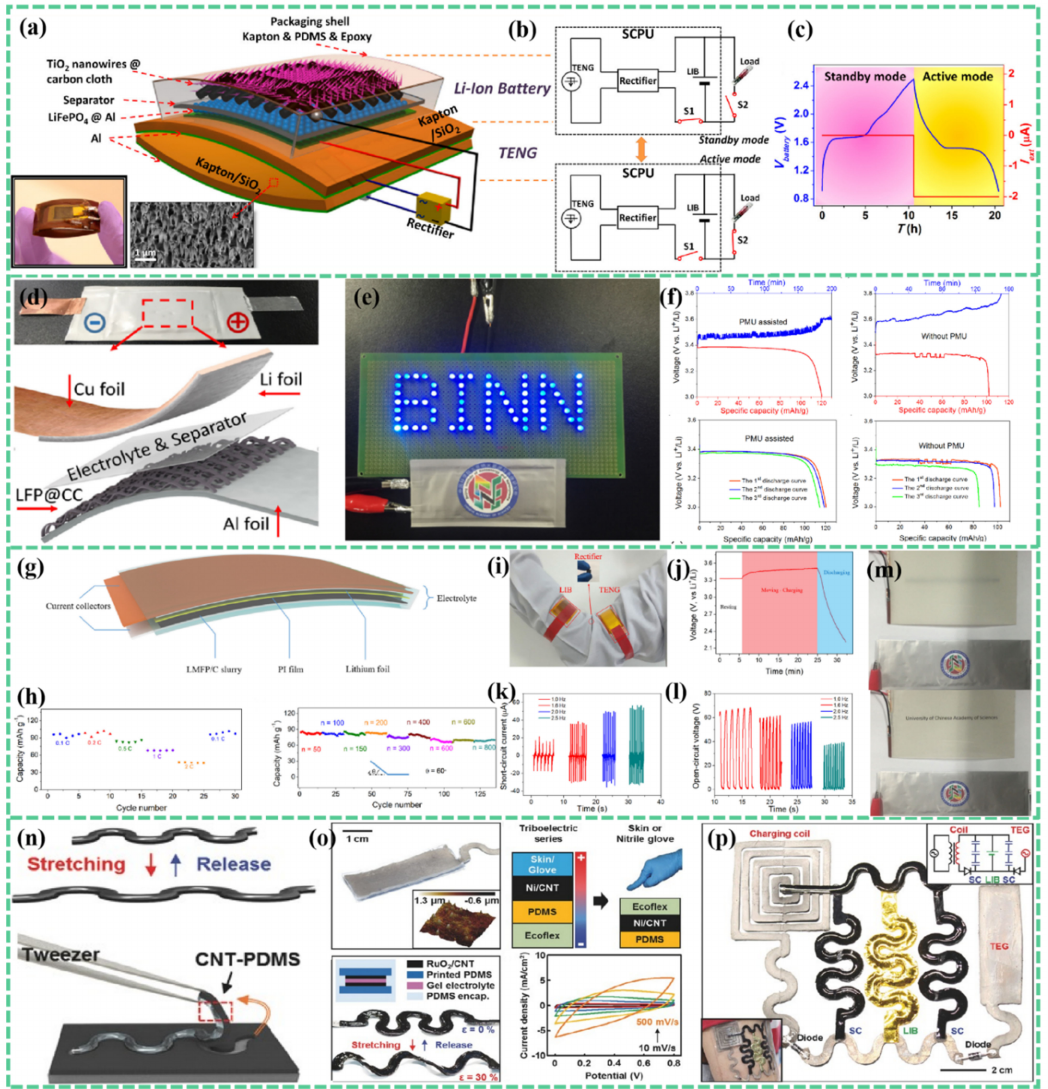
Figure 9. ( a – c ) A mechanical energy collector based on TENG and an uninterrupted power supply unit based on LIB. ( a ) Schematic diagram showing the detailed structure of the TENG-UPS. ( b ) TENG- UPS circuit diagram of TENG component and LIB component integration. ( c ) Voltage distribution diagram. Reproduced with permission [96]. Copyright 2013, American Chemical Society. ( d – f ) A quasi-solid gel electrolyte flexible LIB for storing pulse energy generated by a TENG. ( d ) Photograph and structural schematic of the cell. ( e ) Demonstration of an LED screen showing the letters of BINN. ( f ) Electrochemical performance of the quasi-solid flexible cell. Reproduced with permission